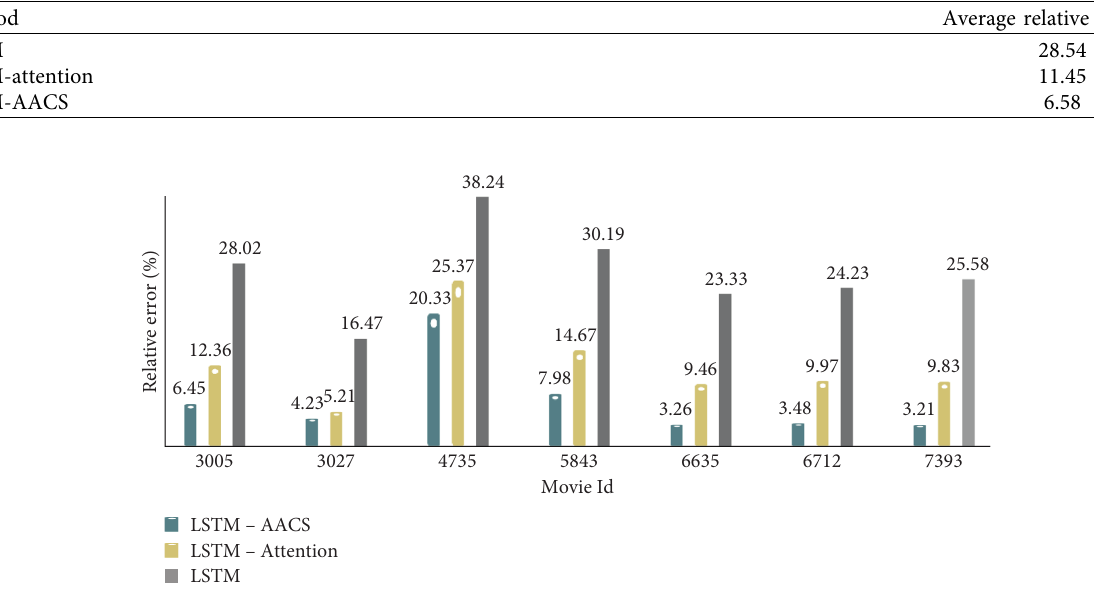
Figure 2: Relative error